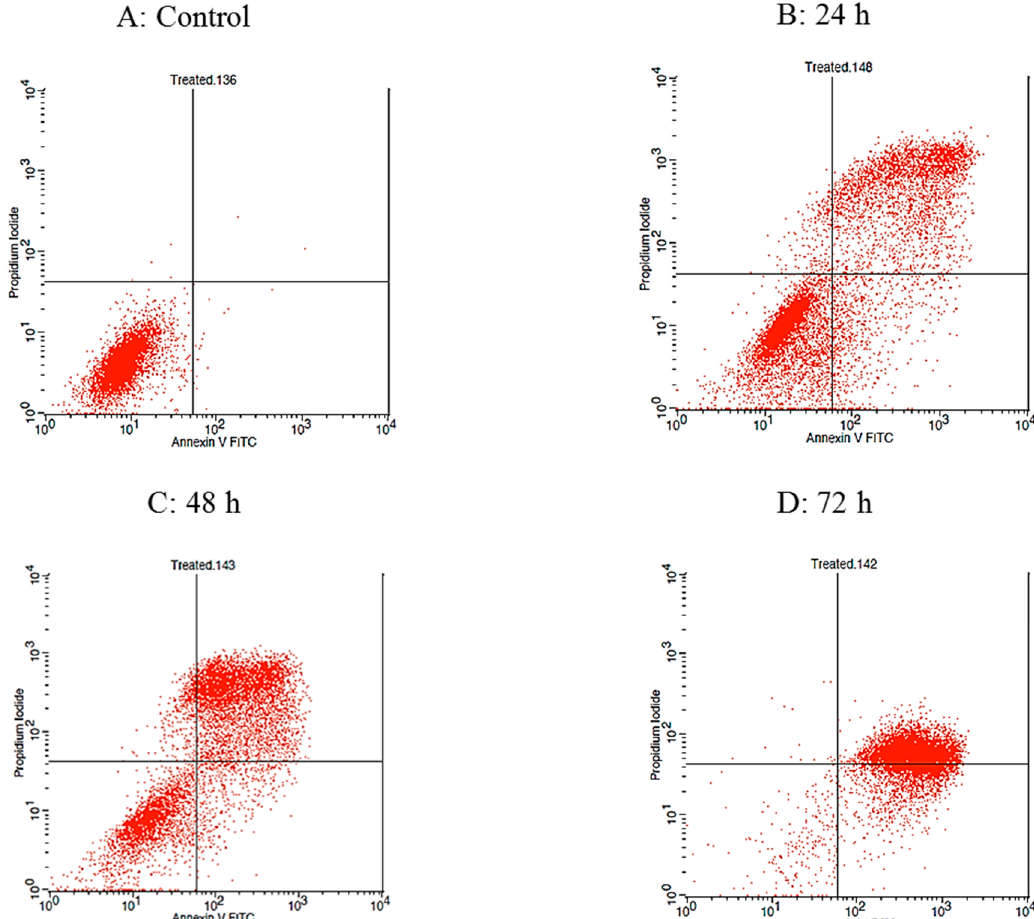
Figure 6. Annexin V-FITC/PI staining to evaluate apoptosis. The MCF-7 cells were treated with IC 50 concentration of raphasatin (9.84 µM), incubated for 24 (B), 48 (C), and 72 h (D) and compared with untreated cells ( A ). The rate of apoptosis was determined by flow cytometry, using the Annexin V-FITC/PI staining assay. The data represent one of three independent experiments. (i) Lower left quadrant represents the viable cells, (ii) lower right quadrant shows the early apoptosis cells, (iii) upper right quadrant signifies the late apoptosis cells, and (iv) the upper left quadrant indicates dead cells.